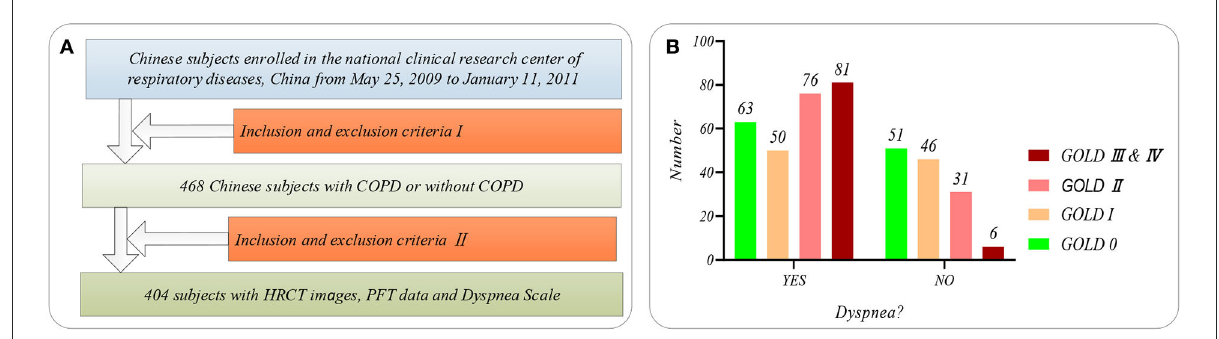
FIGURE1 The subjects’ selection flow diagram and dyspnea distribution in this study. (A) The subjects’ selection flow diagram, including the enrollment and the inclusion and exclusion criteria I and II; (B) Dyspnea distribution of the subjects at GOLD